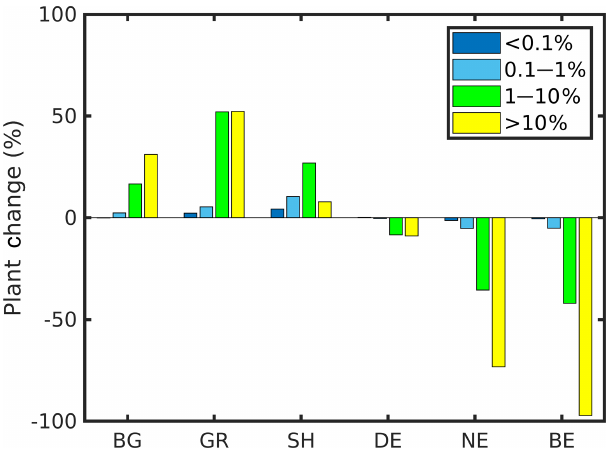
Figure 5. Differences in vegetation distribution (bare ground (BG), grass (GR), shrub (SH), deciduous (DE), broadleaf evergreen (BE), and needleleaf evergreen (NE)) ratios between BGC-DV-F and BGC-DV-NF for four burned area categories: under 0.1%, 0.1%– 1%, 1%–10%, and greater than 10%.